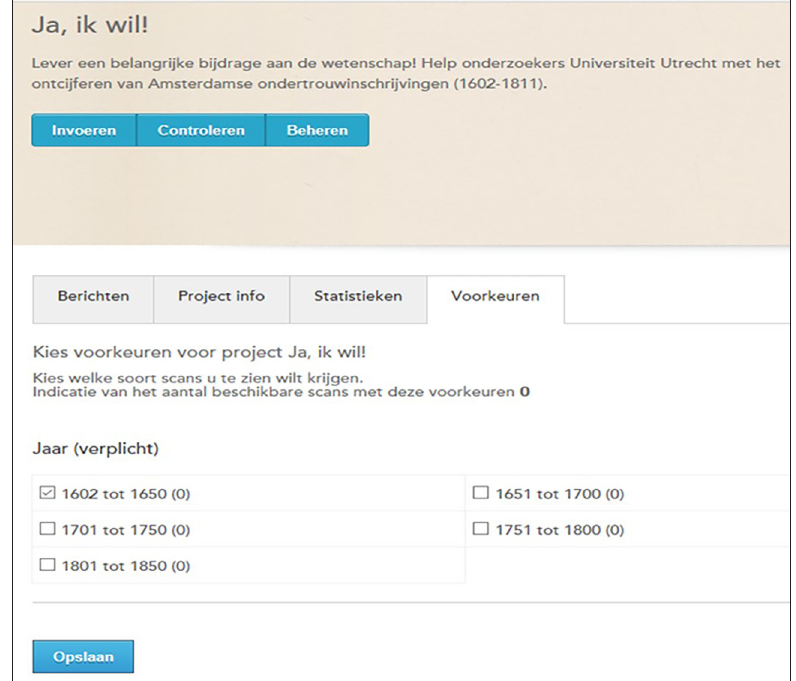
Figure 6: Project page where volunteers could choose the period (difficulty) of the scans to transcribe. Source: Vele